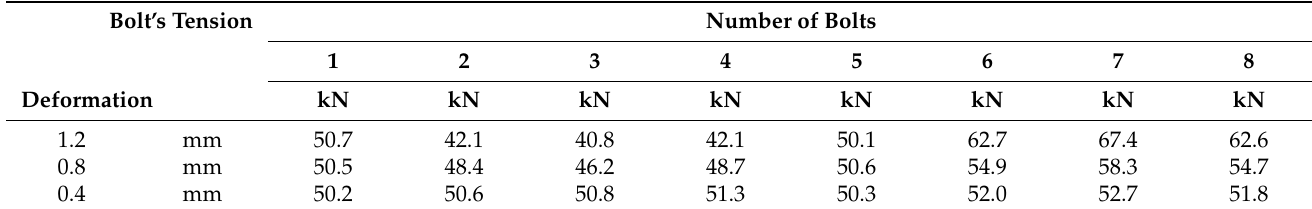
Table 4. Bolts’ tensions as a function of pipeline deflection.